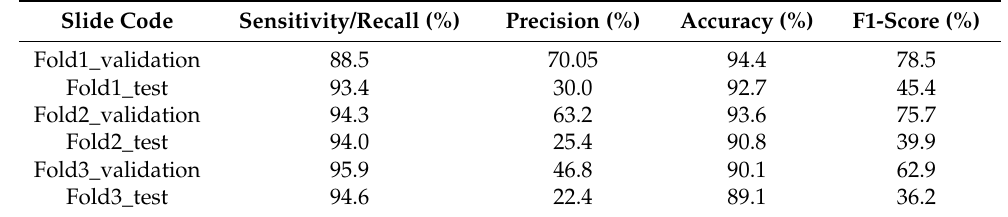
Table 3. Accuracy, sensitivity precision and F1 score for validation and test for folds 1, 2 and 3.